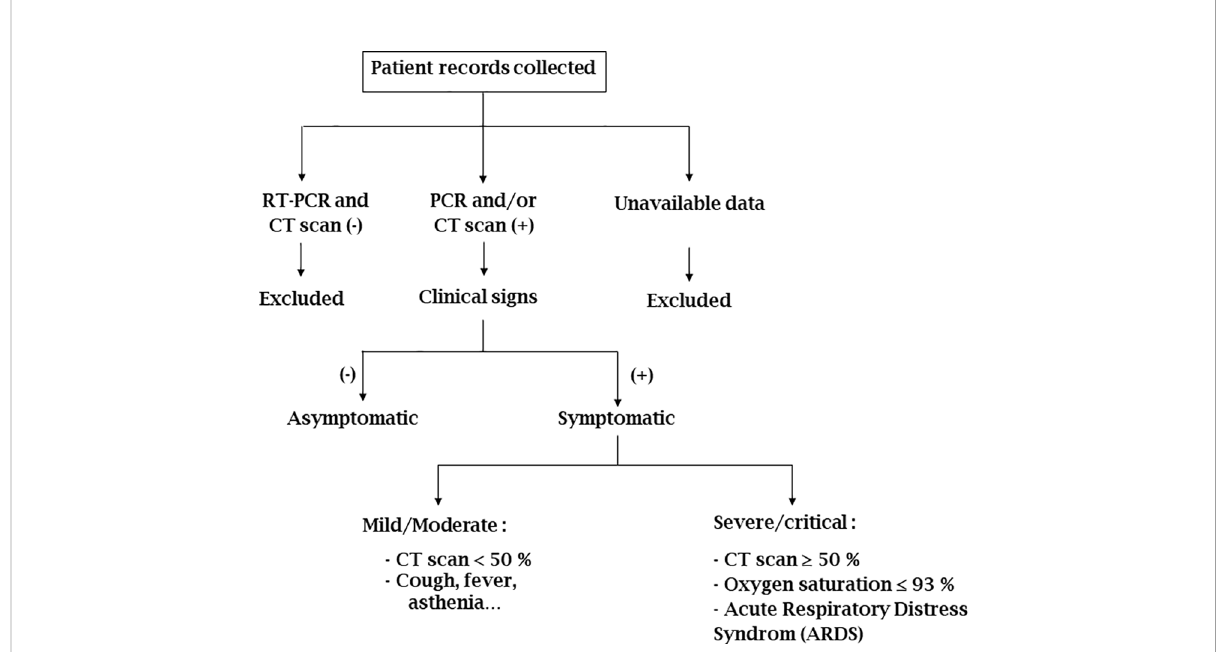
FIGURE 1 Chart on the use of data collected from COVID-19 patients for the study. (-): negative; (+): positive; CT scan < 50% and ≥ 50%: percentage of lung lesion revealed by Thoracic Computed